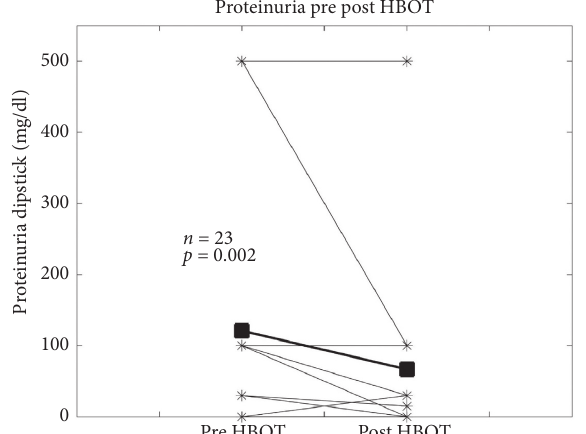
Figure 2: All available proteinuria levels before and after hyperbaric oxygen therapy (HBOT). Asterisks show the individual results, and the squares are the mean. The Wilcoxon signed-rank test was used to calculate the p value.